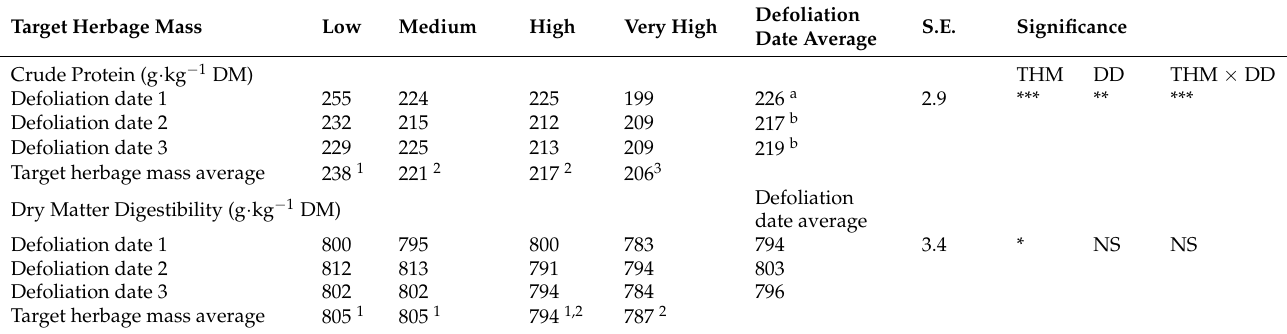
Table 3. Effect of the interaction of target herbage mass (Low—500 kg · DM · ha − 1 , Medium—1500 kg · DM · ha − 1 , High— 2000 kg · DM · ha − 1 and Very high—3000 kg · DM · ha − 1 ) and defoliation dates (DD; DD1—15 October, DD2—7 November and DD3—21 November) at defoliation in autumn on the crude protein (g · kg − 1 DM) and dry matter digestibility (DMD; g · kg − 1 DM).